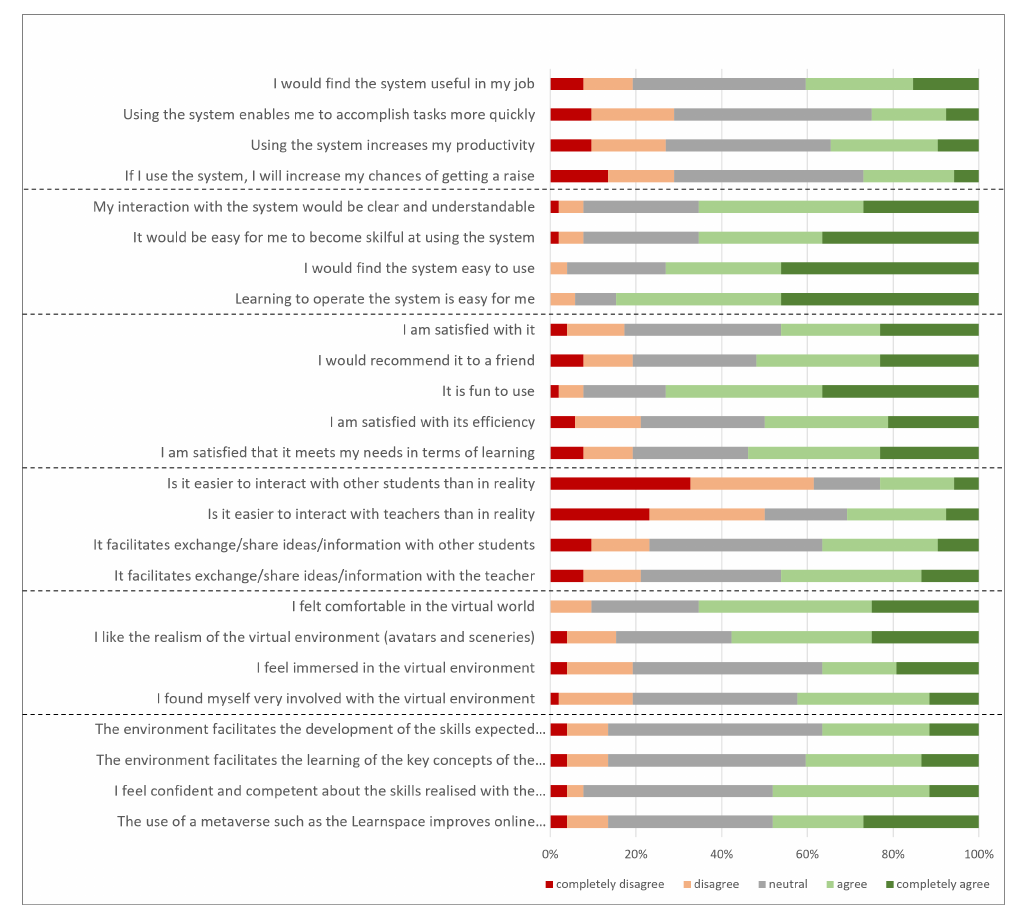
Figure 2. Summarized overview of the survey